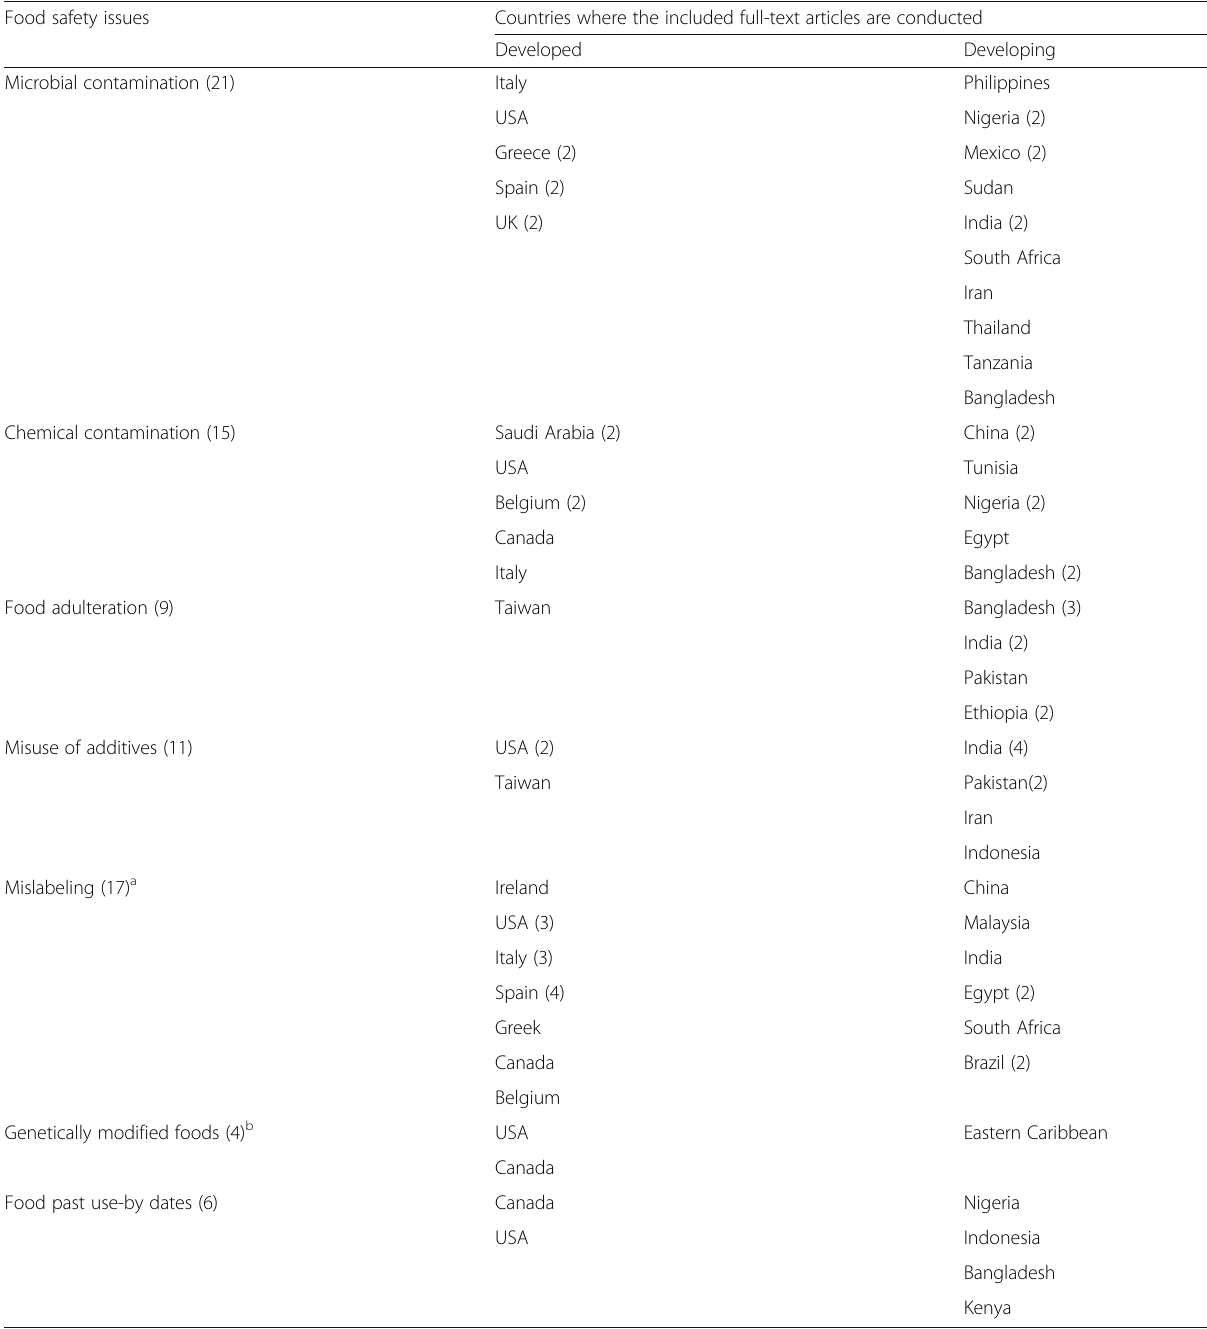
Table 2 Food safety – related public health risks in the food market by country name (countries are categorized into developed and developing based on the United Nations (UN) 2019